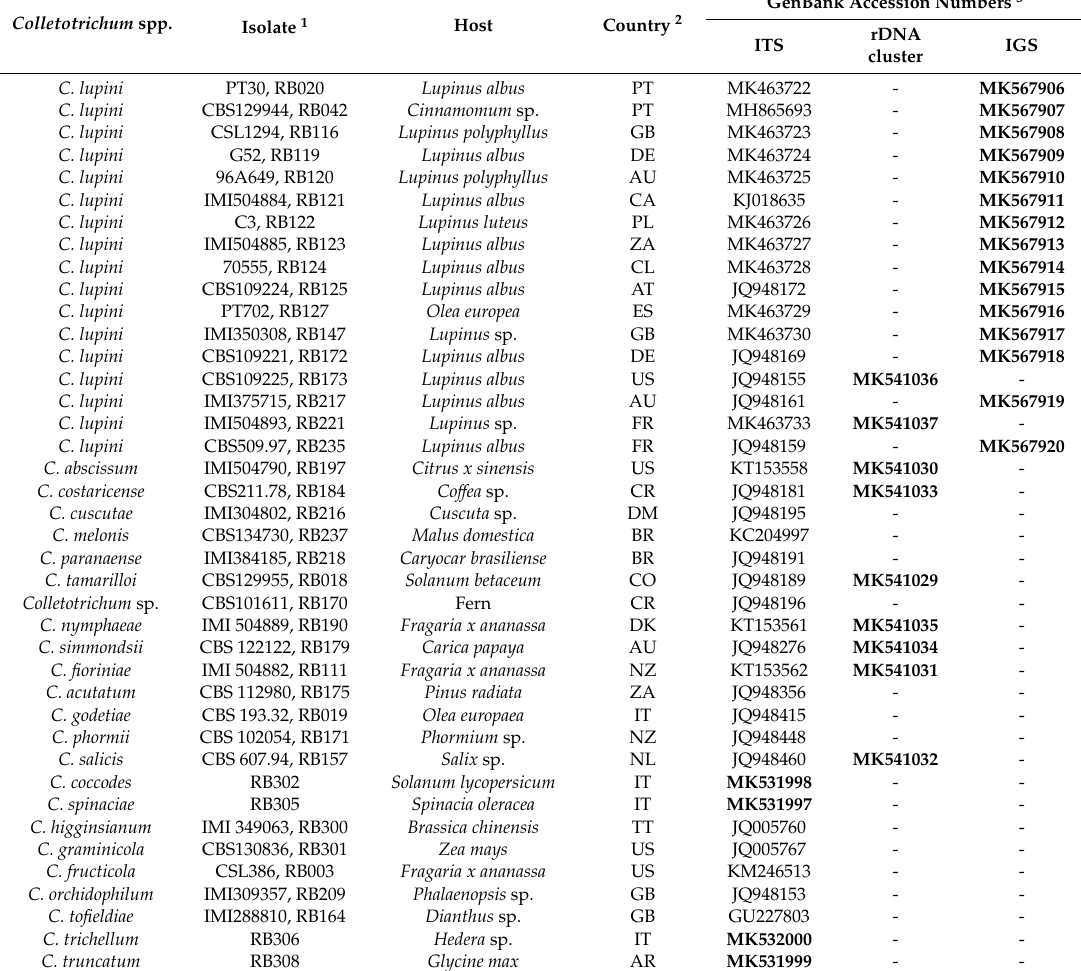
Table 2. Colletotrichum isolates used in this study and relative information. Colletotrichum